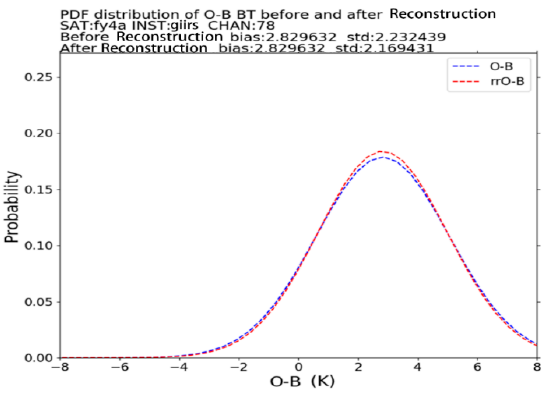
Figure 7. Array distribution characteristics of the ( a ) background departures (O-B); ( b ) reconstructed background departures (rrO-B) and ( c ) reconstructed observation departures (rrO-O) in the clear-sky sea area of channel 78.